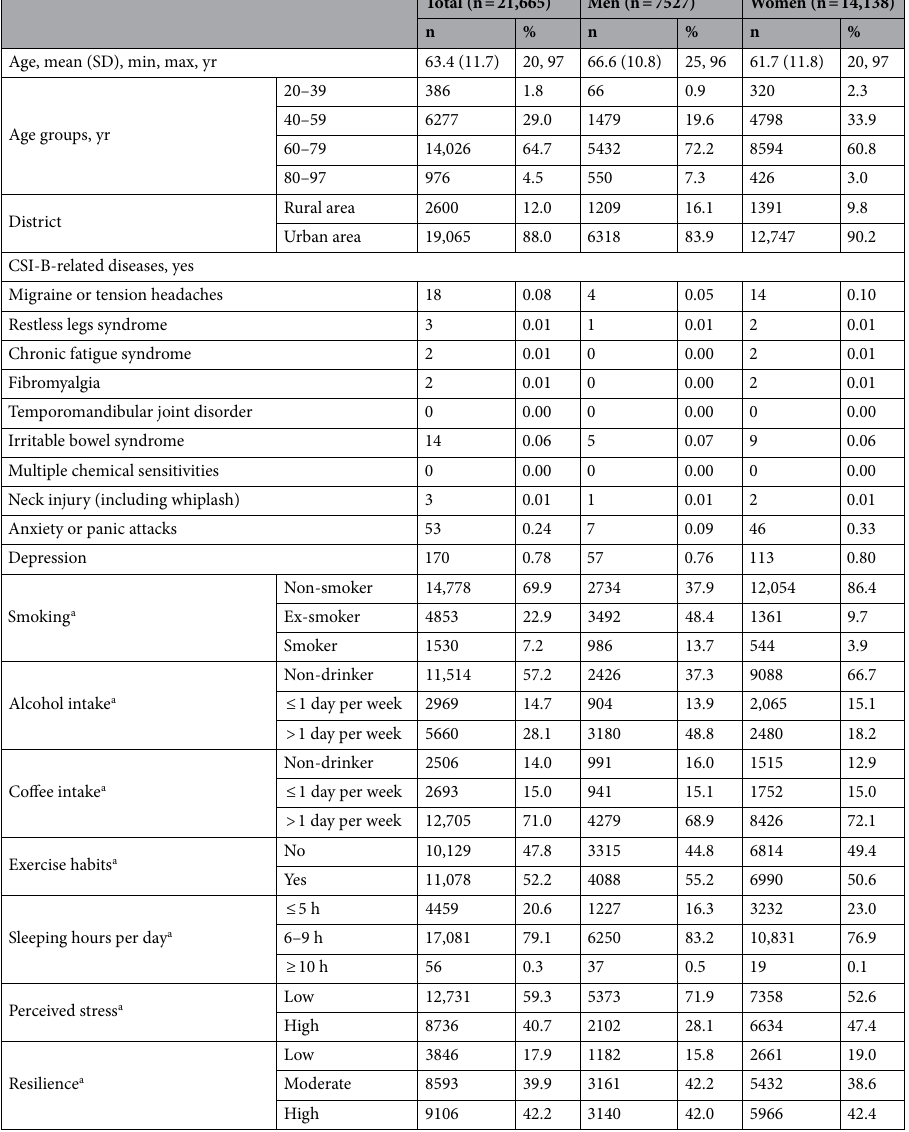
Table 1. Characteristics of participants by sex. CSI Central sensitization inventory. a Participants with missing values for smoking (n = 494), alcohol intake (n = 1522), coffee intake (n = 3761), exercise habits (n = 458), sleeping hours per day (n = 69), perceived stress (n = 198), and resilience (n = 120) were